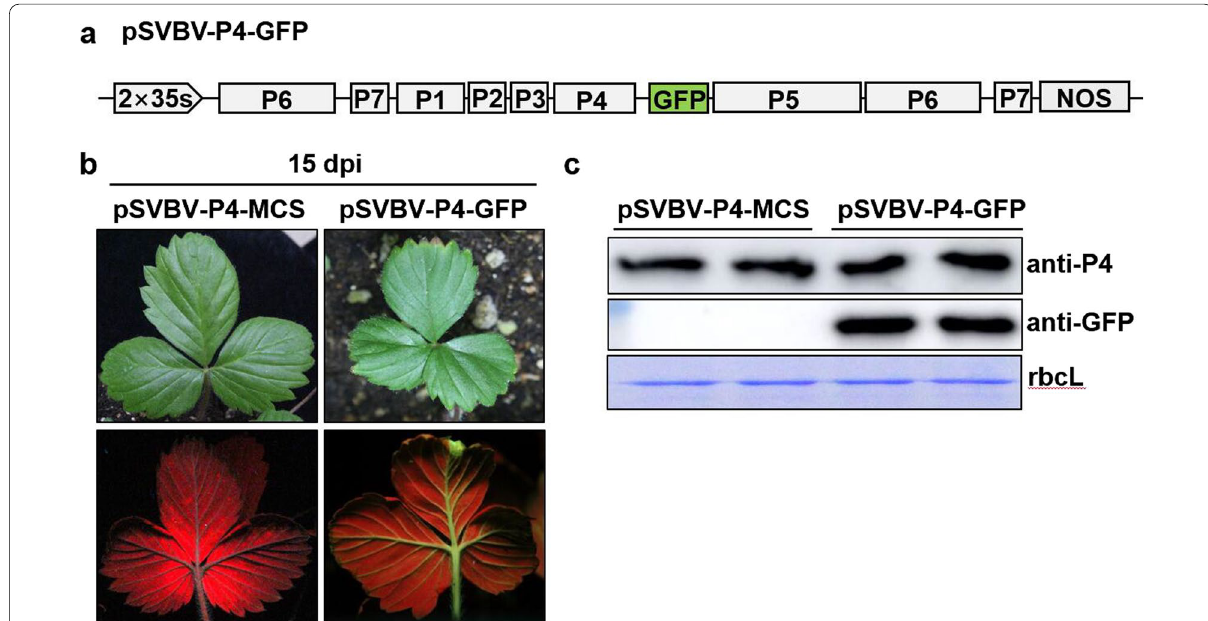
Fig. 4 Expression of GFP in strawberry plants using the pSVBV-P4-GFP vector. a Schematic representation of the overexpression vector pSVBV-P4-GFP. The GFP gene was cloned into pSVBV-P4-MCS via the Pml I- Bam HI sites. b Detection of fluorescence signals in the leaves of strawberry plants inoculated with pSVBV-P4-MCS or pSVBV-P4-GFP. Backs of the strawberry leaves were illuminated under UV-B light. c Western blot analysis of leaf samples shown in ( b ) using antibodies for SVBV P4 and GFP. Coomassie brilliant blue (CBB)-staining of the RuBisCO large subunit (rbcL) was used as a loading control